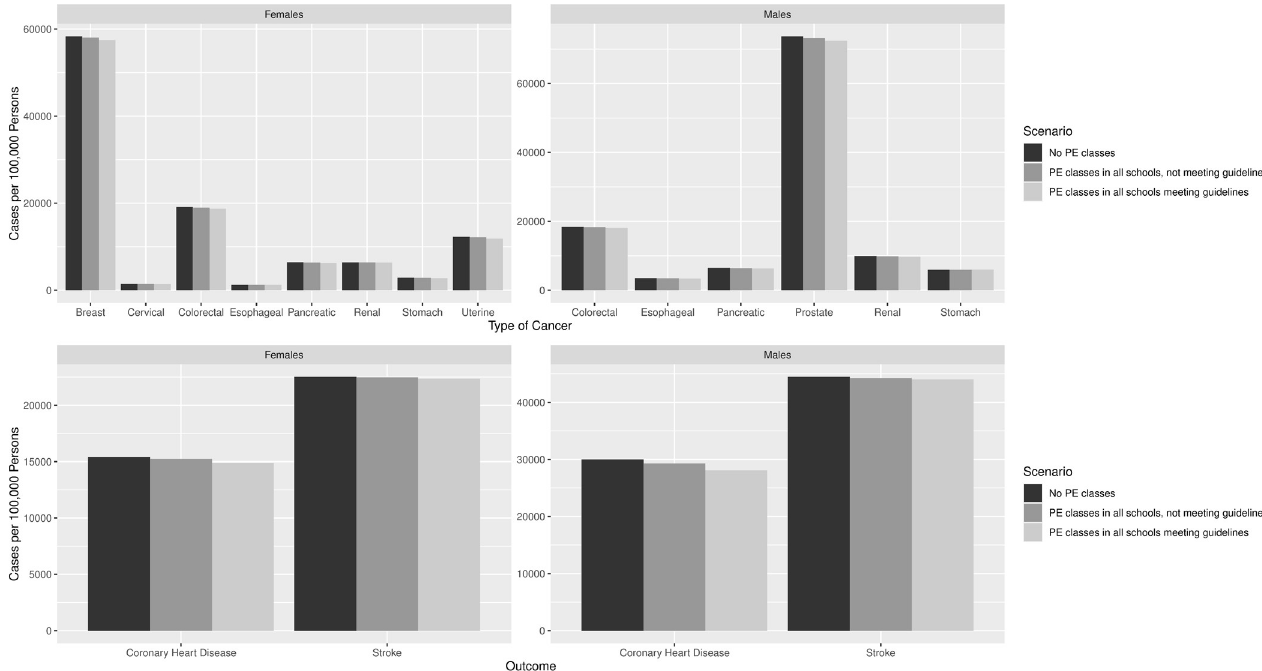
Fig 2. Cancer, stroke, and coronary heart disease (CHD) outcomes for males and females when no schools offer physical education (PE) classes and when requiring PE classes per 100,000 persons.